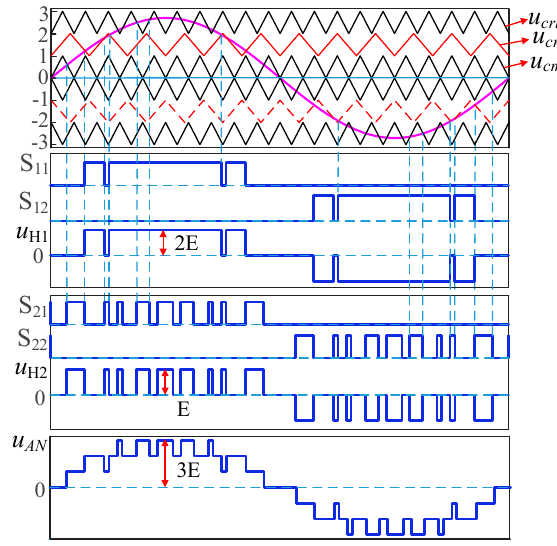
Figure 5. Hybrid frequency modulation schematic (Reference [16]).